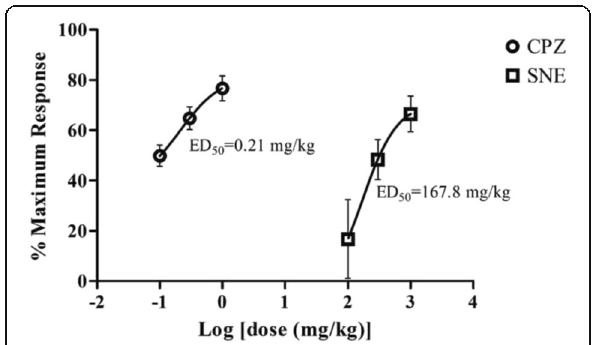
Fig. 6 A dose-response effect of SNE (100 – 1000 mg/kg) and CPZ (0.1 – 1 mg/kg) against apomorphine-induced stereotypy behaviour in mice. Data are mean ± SEM ( n = 5)